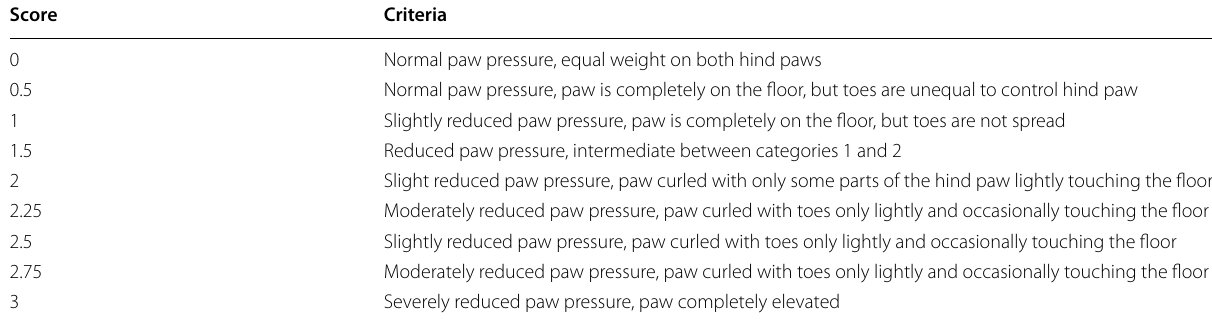
Table 2 Scoring system for visual weight-bearing test